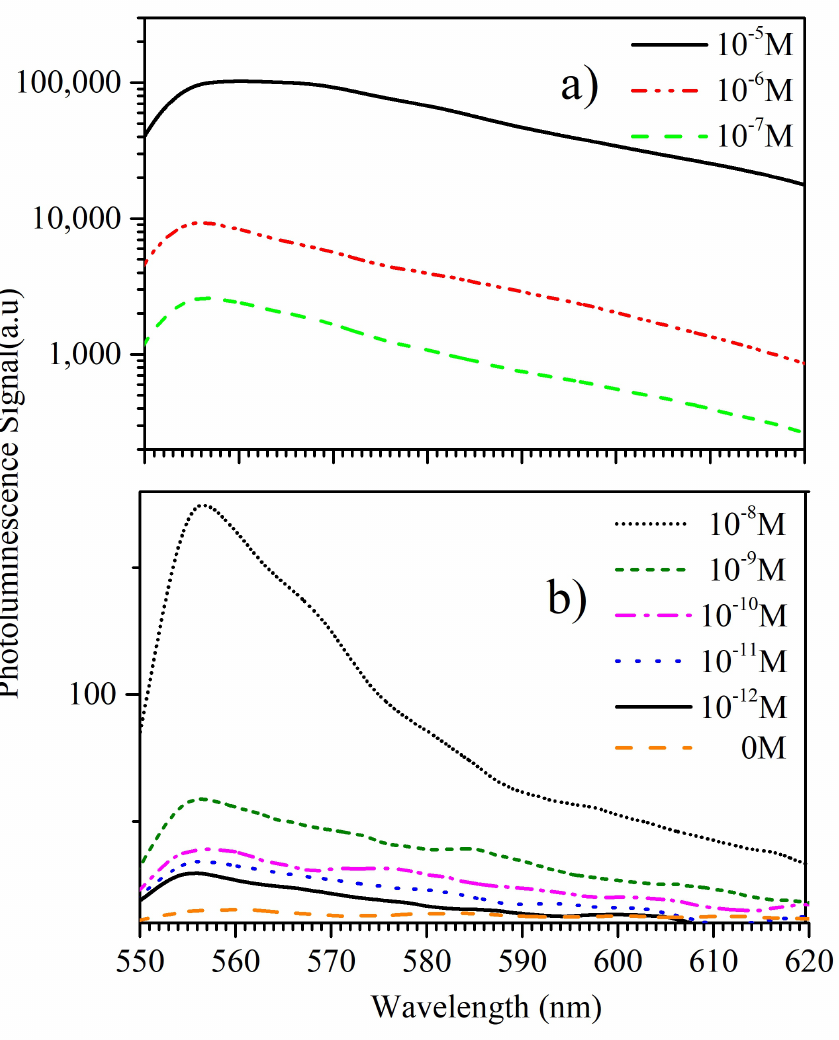
Figure 7. Photoluminescence spectra for various R6G concentrations ( a ) in log scale for the higher con- centrations and ( b ) in linear scale for lower concentrations, obtained on Ag-dendrites/Au substrates in comparison with PL signal from R6G-free